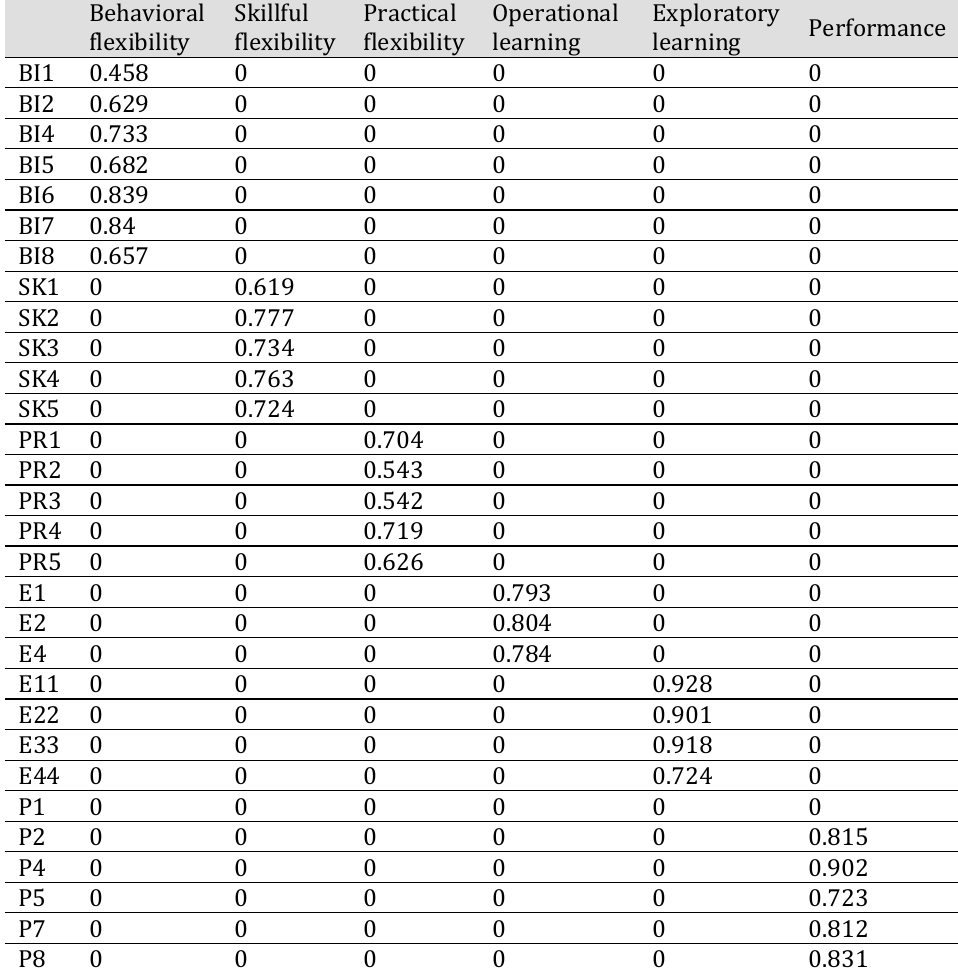
Table 3. Convergent validity analysis through Cross-Factor Loads